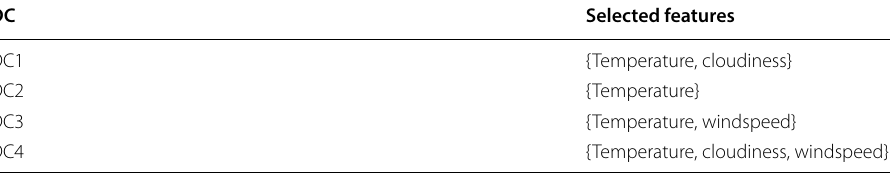
Table 4 Result of identifying most significant feature in DCs